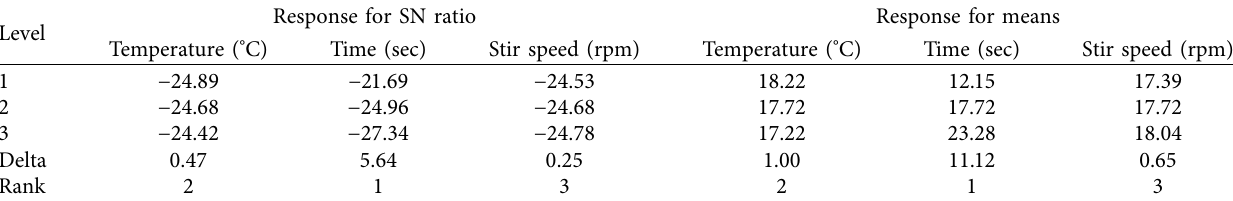
Table 3: Significant consequence for porosity.